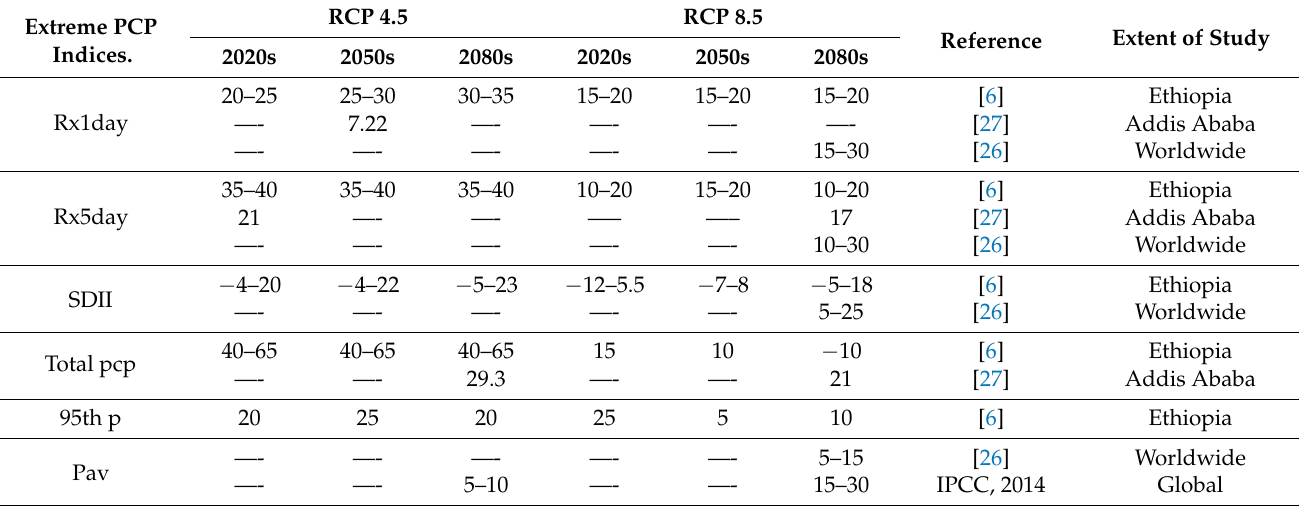
Table 1. Extreme precipitation indices and their corresponding changes within the study area using various work of the literature. Extreme PCP Indices.